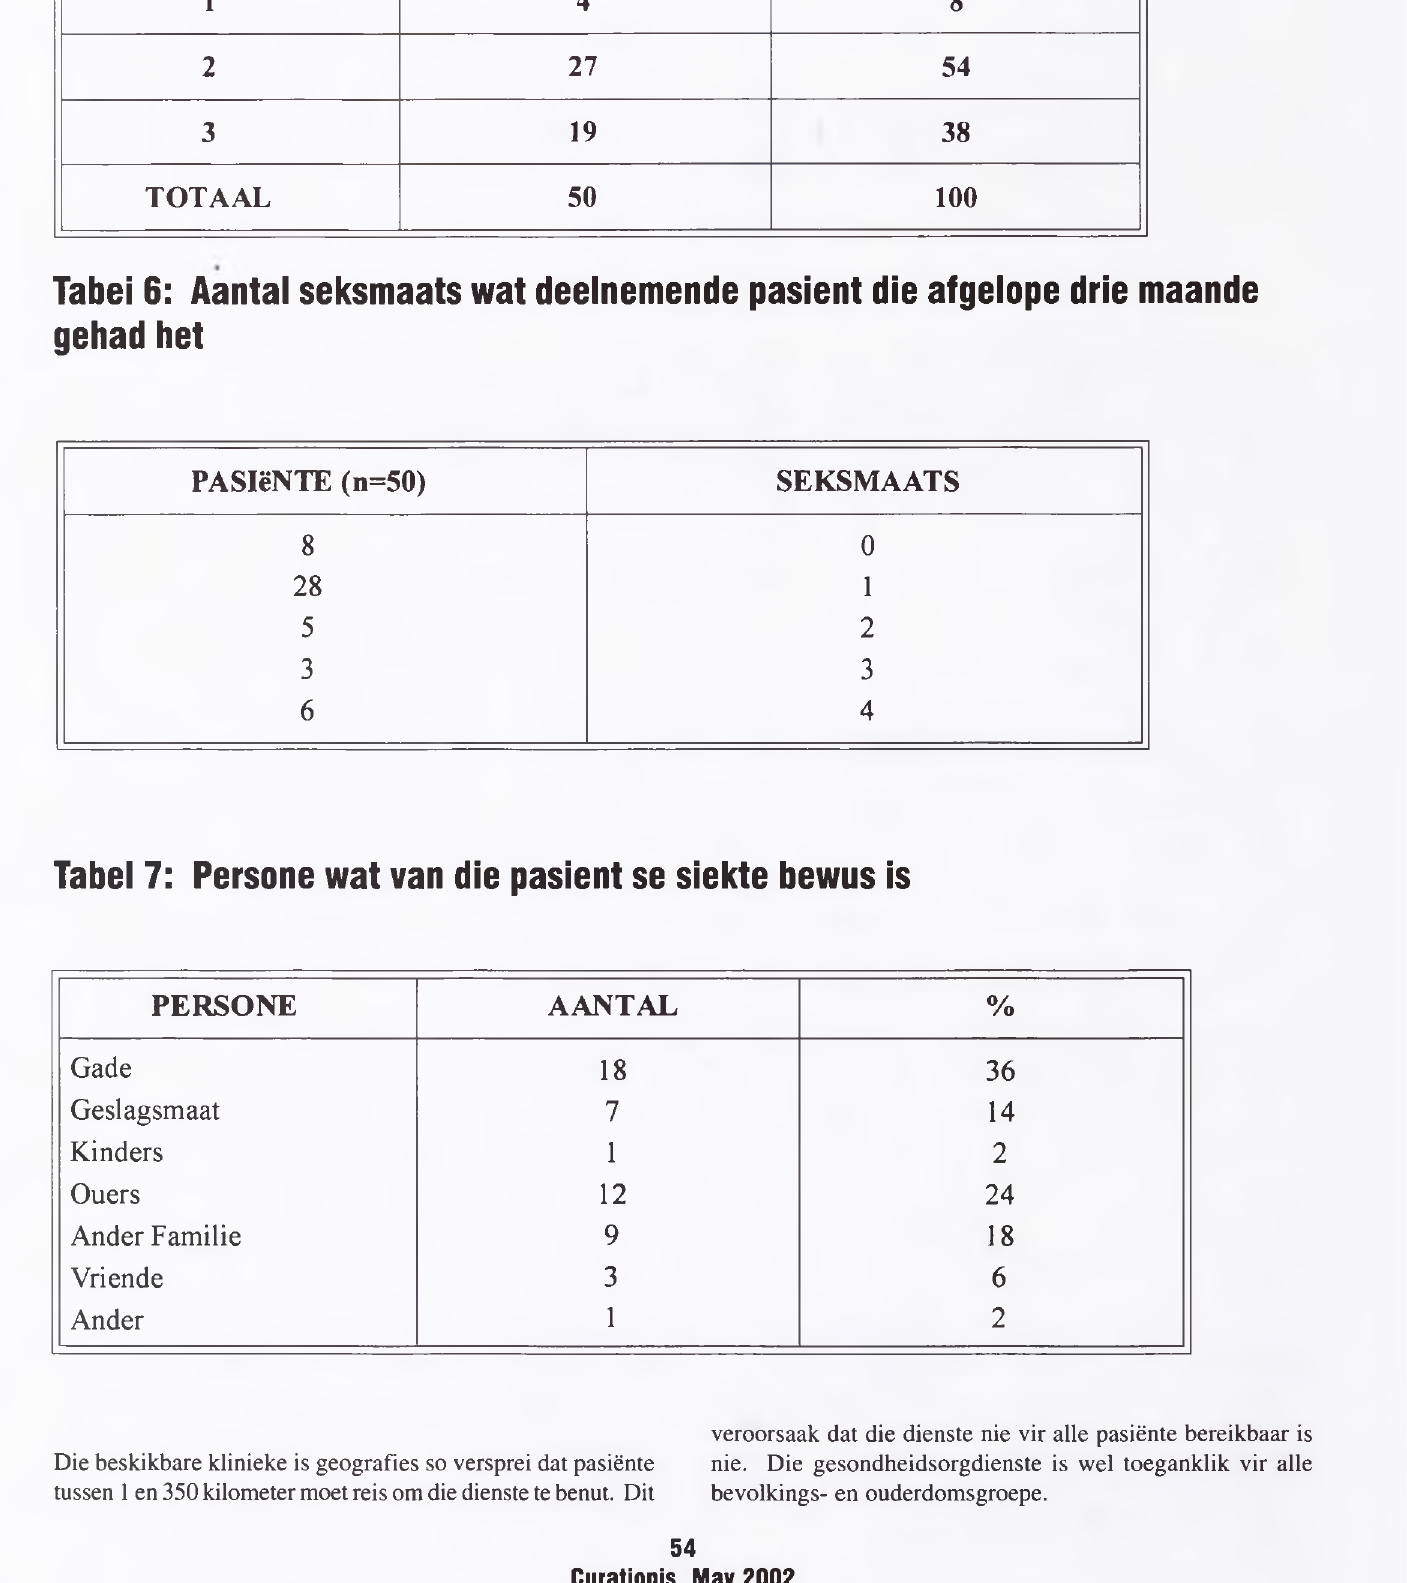
Tabel 5: Stadium van siekte waarin die pasient verkeer